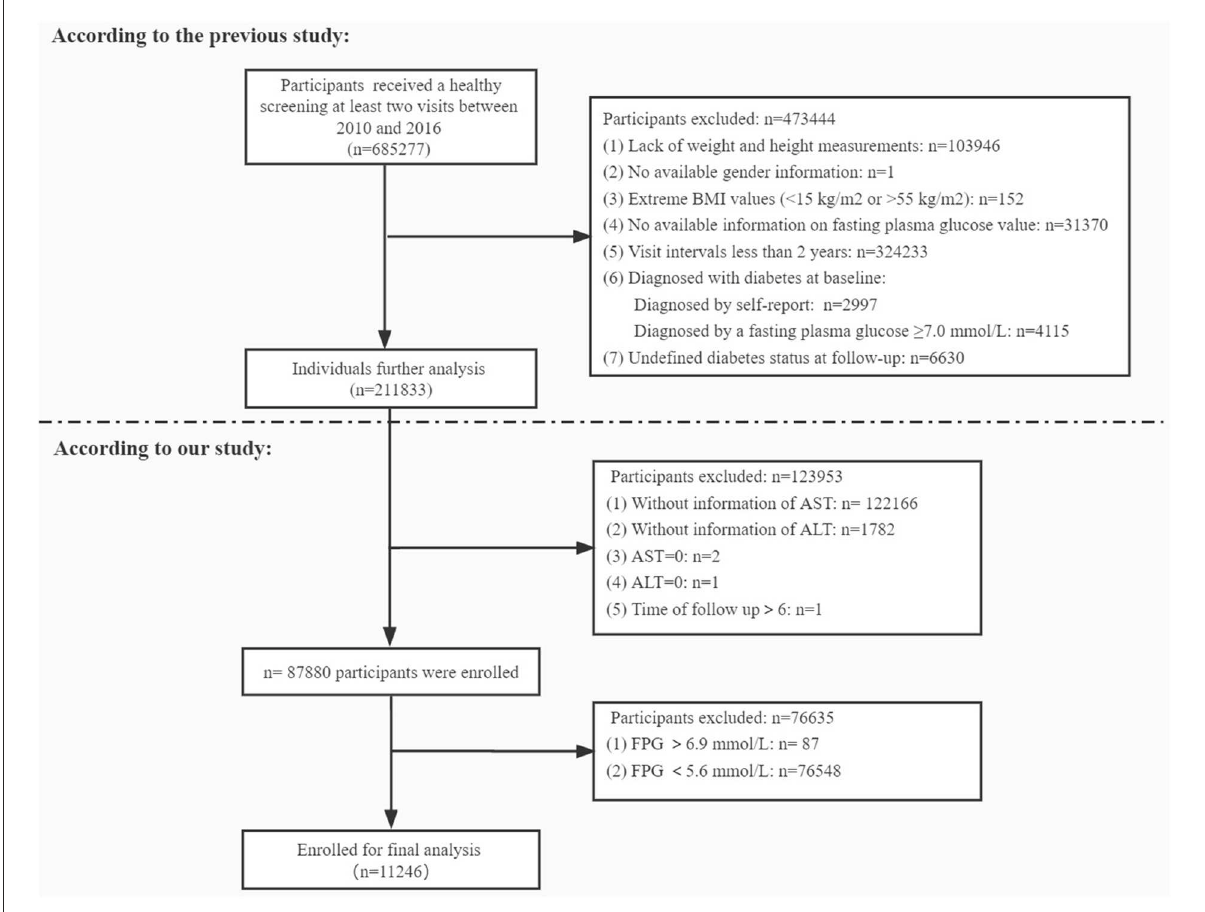
FIGURE1 Flow chart of the study